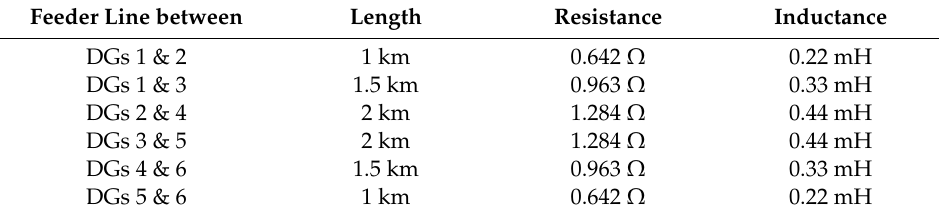
Table 1. The feeder line parameters.